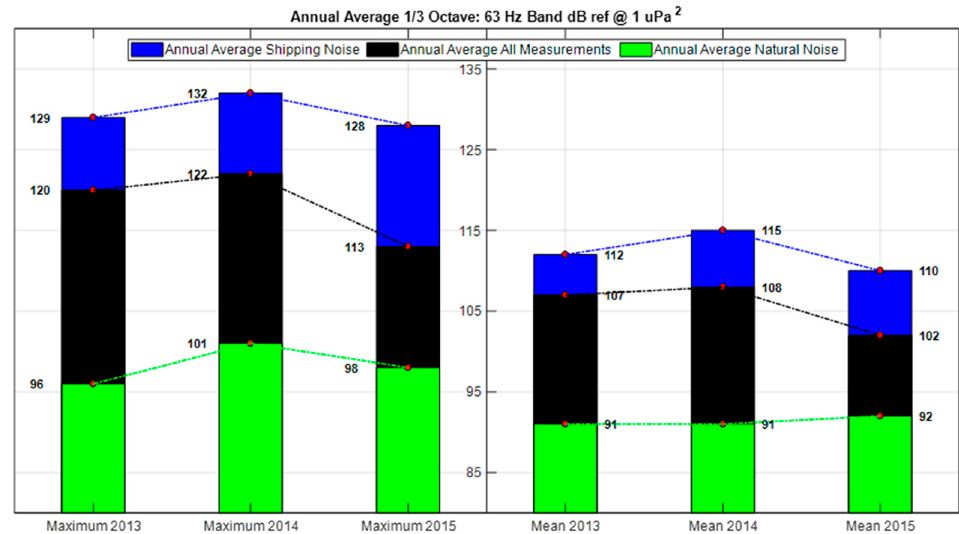
Figure 12. Annual average of the maximum ( left ) and mean ( right ) levels of the 1/3 octave band centered at 63 Hz of the three groups of measurements according to the identification of the acoustic sources.